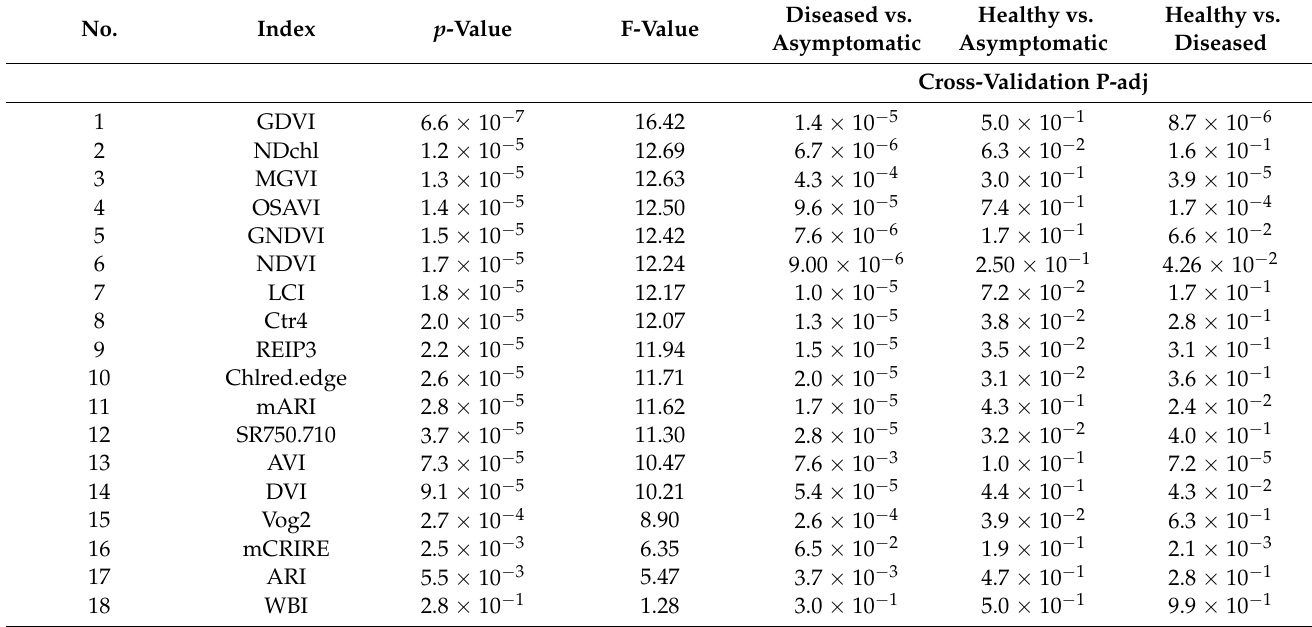
Table A2. Parametric ANOVA and its relative cross-validation results for the